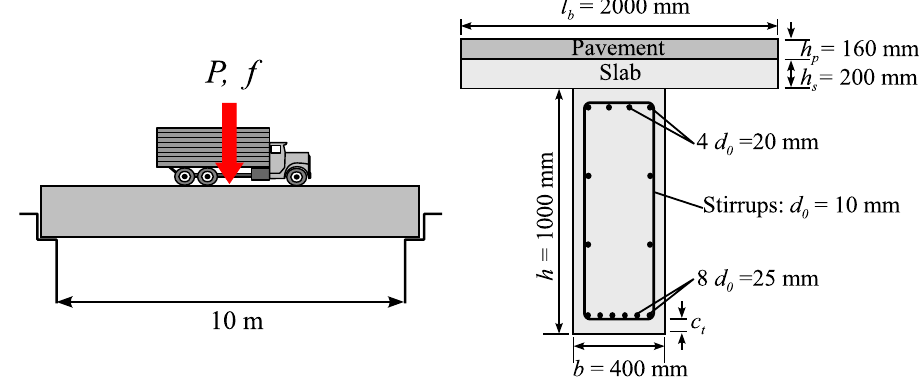
Fig. 3 Configuration of the bridge